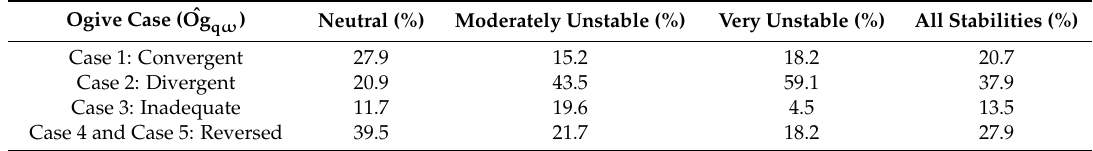
Table 4. Classification fractions of the Ogives for latent heat flux (corresponding to bottom panels in Figure 2). The numbers are the fraction of Ogives in a given category (column) under the given classification